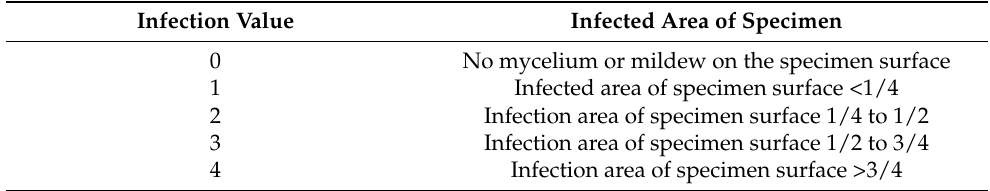
Table 1. The grading standard of the surface infection value of mildews for samples. Infection Value Infected Area of Specimen 0 No mycelium or mildew on the specimen surface 1 Infected area of specimen surface <1/4 2 Infection area of specimen surface 1/4 to 1/2 3 Infection area of specimen surface 1/2 to 3/4 4 Infection area of specimen surface